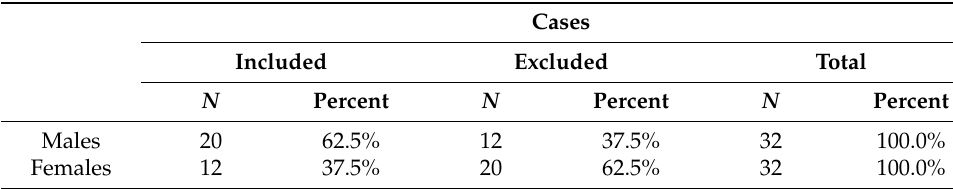
Table 1. Gender distribution.